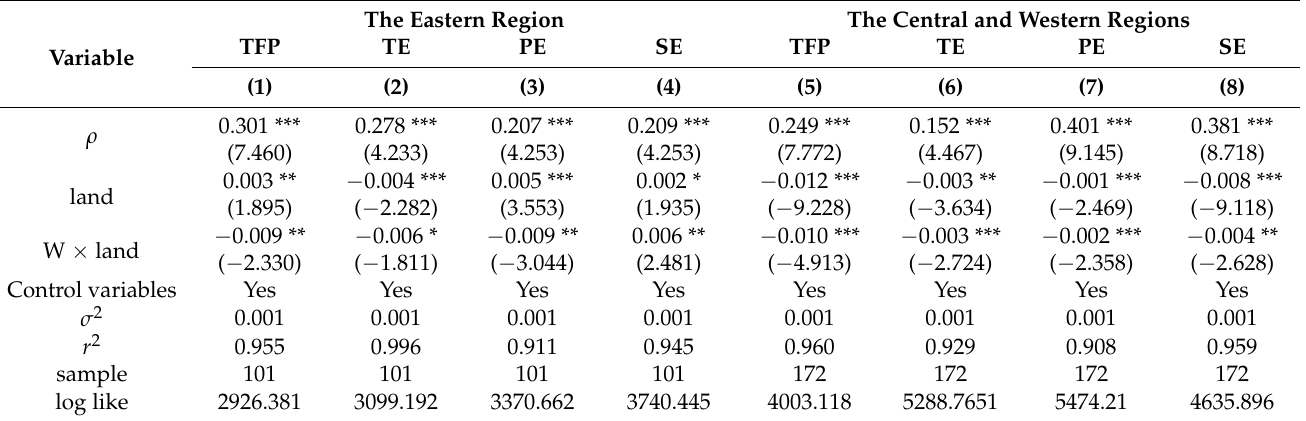
Table 6. Spatial econometric regression results for different regions. The Eastern Region The Central and Western Variable